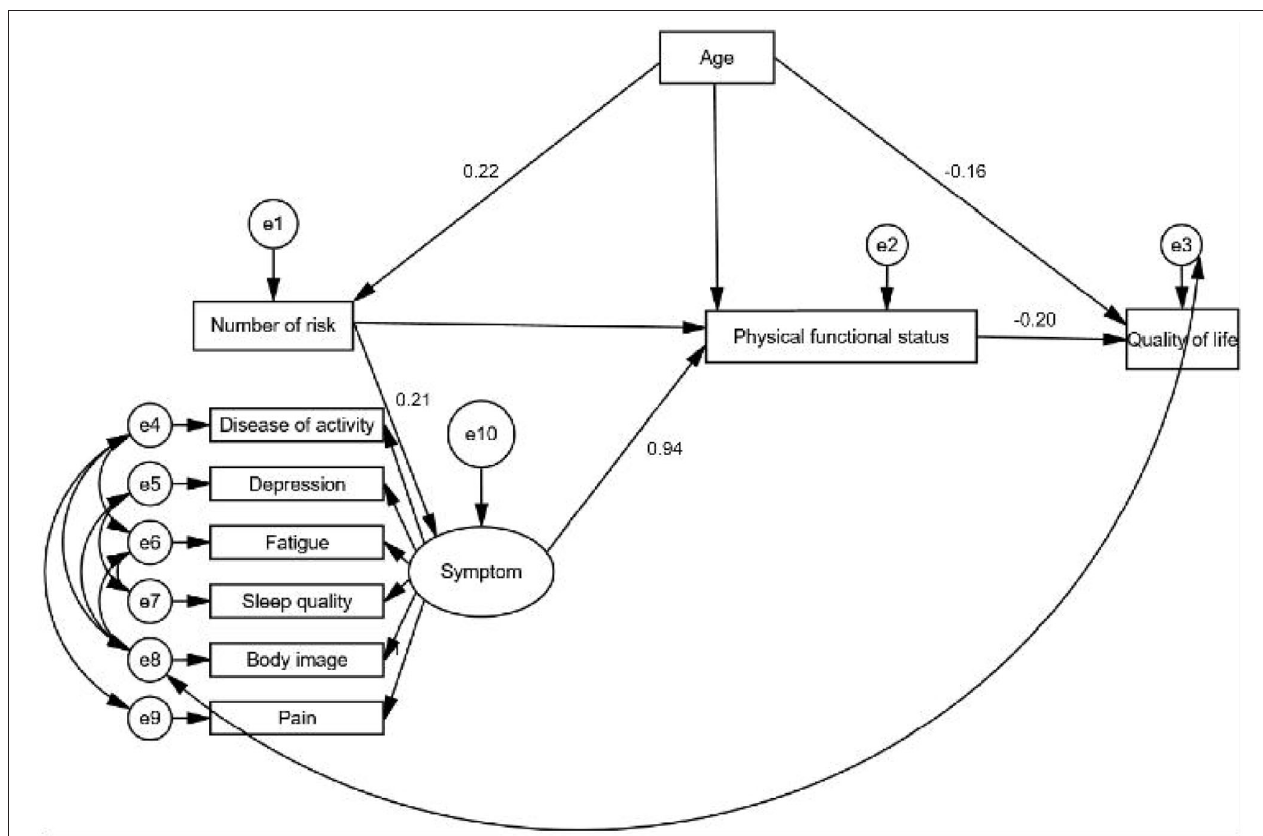
FIGURE 2 | Goodness of fit of structural equation models of variables in a cross-sectional study of health-related quality of life. (1) Latent variable: biological and physiological status; measured variables: number of risk factors (e.g., hyperlipidemia, diabetes). (2) Latent variable: symptom status; measured variable: BIDQ, DAS28, HADS, FSS, PSQI, and GPS. BIDQ, Body Image Disturbance Questionnaire; DAS28, Disease Activity Score in 28 joints; HADS, Hospital Anxiety and Depression Scale; FSS, Fatigue Severity Scale questionnaire; PSQI, Pittsburgh Sleep Quality Index; GPS, Global Pain Scale. (3) Latent variable: physical functional status; measured variable: physical function status was based on the total score of “go to the store,” “do chores in my home,” “enjoy my friends and family,” “exercise,” and “participate in my favorite hobbies” in GPS. GPS, Global Pain Scale. (4) Latent variable: QoL; measured variable: SF-36 total score. QoL, quality of life; SF-36, Short Form 36 Health Survey. (5) Latent variable: characteristics of the environment; measured variable: social support. (6) Latent variable: characteristics of the individual measured variable: demographic characteristics (age, education, income,